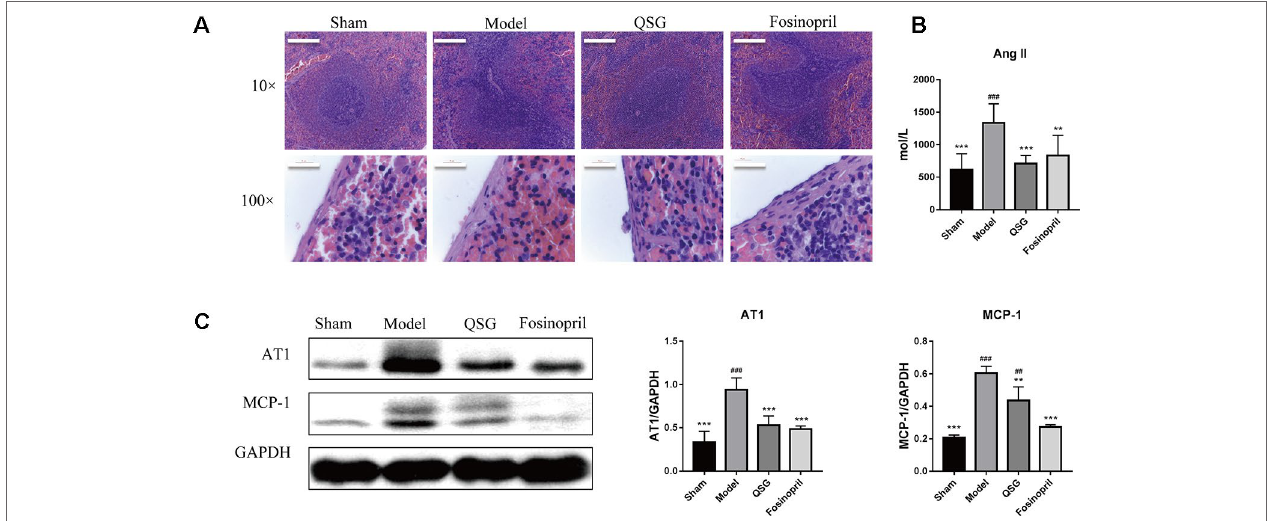
FIGURe 1 | QSG inhibited the release of monocytes from the spleen. (a) HE staining showed that monocytes in the marginal zone of the spleen were released in the model group, and QSG could exert the protective effect by increasing the number of monocytes in red pulp under the capsule and marginal zone of the spleen. (B) . QSG significantly decreased the circulatory level of angiotensin II. (C) Western blot showed that QSG reduced the expressions of AT1 and MCP-1 in splenic tissues. All data were presented as means ± SD from independent experiments performed in triplicate. ## P < 0.01, ### P < 0.001 vs the sham group; ** P < 0.01, *** P < 0.001 vs the model group. N = 3 per